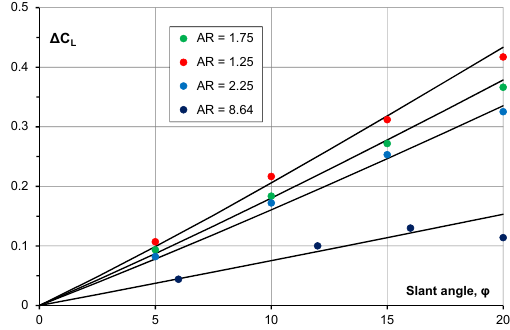
Figure A3. Lift increase as a function of slant angle.